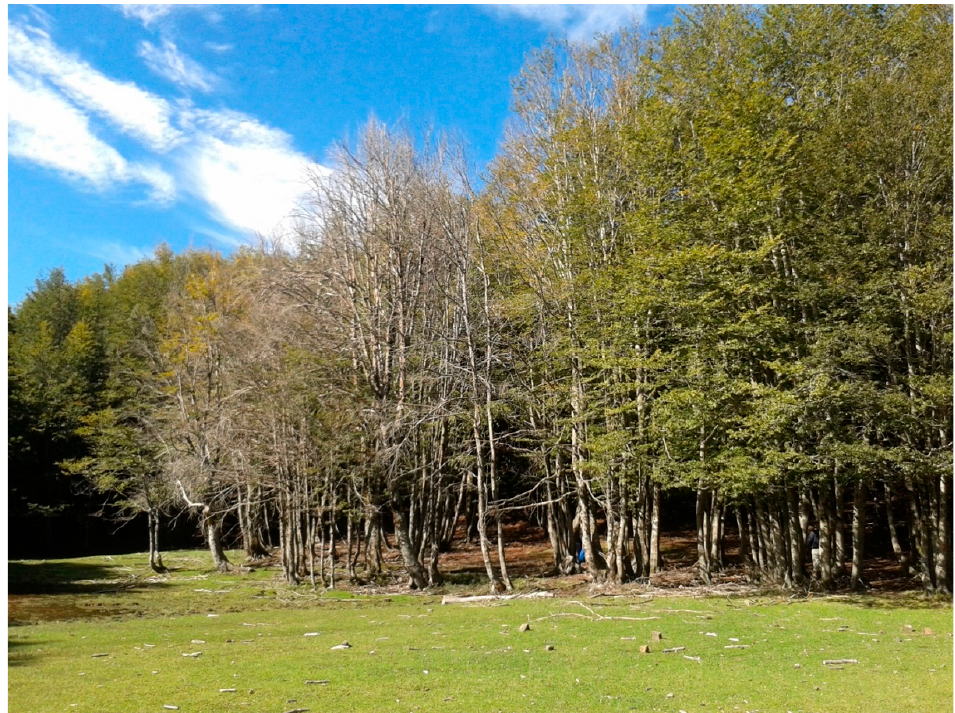
Figure 2. A group of European beech ( Fagus sylvatica ) trees with severe symptoms of decline on the shore of a seasonal water basin in the Nebrodi Regional Park (Sicily, southern Italy).